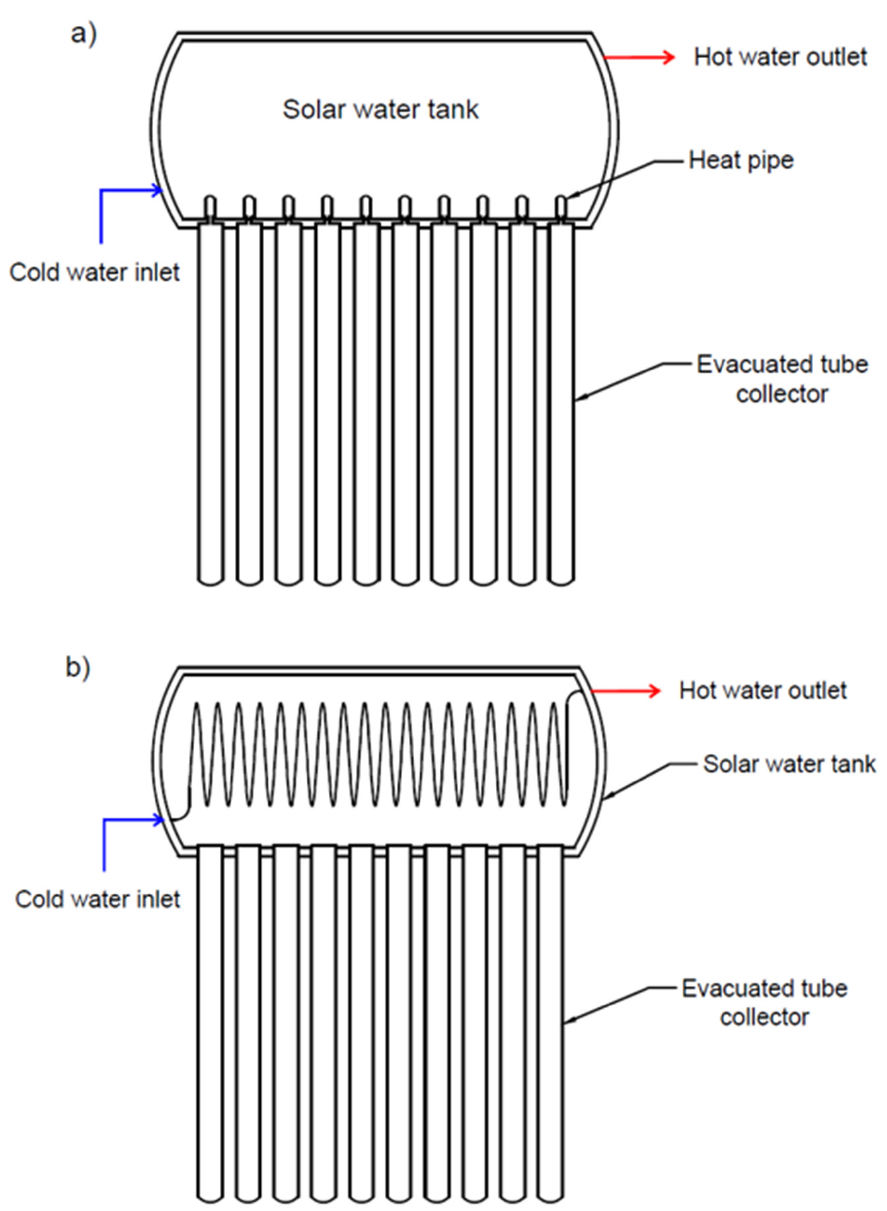
Figure 7. Indirect, compact solar water heater designs with ( a ) regular water tank and heat pipe ETC and ( b ) copper coil-integrated water tank and water-in-glass ETC [57].